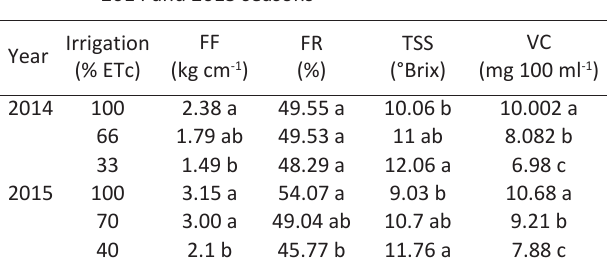
Table 5 - Effect of deficit irrigation on fruit firmness (FF),